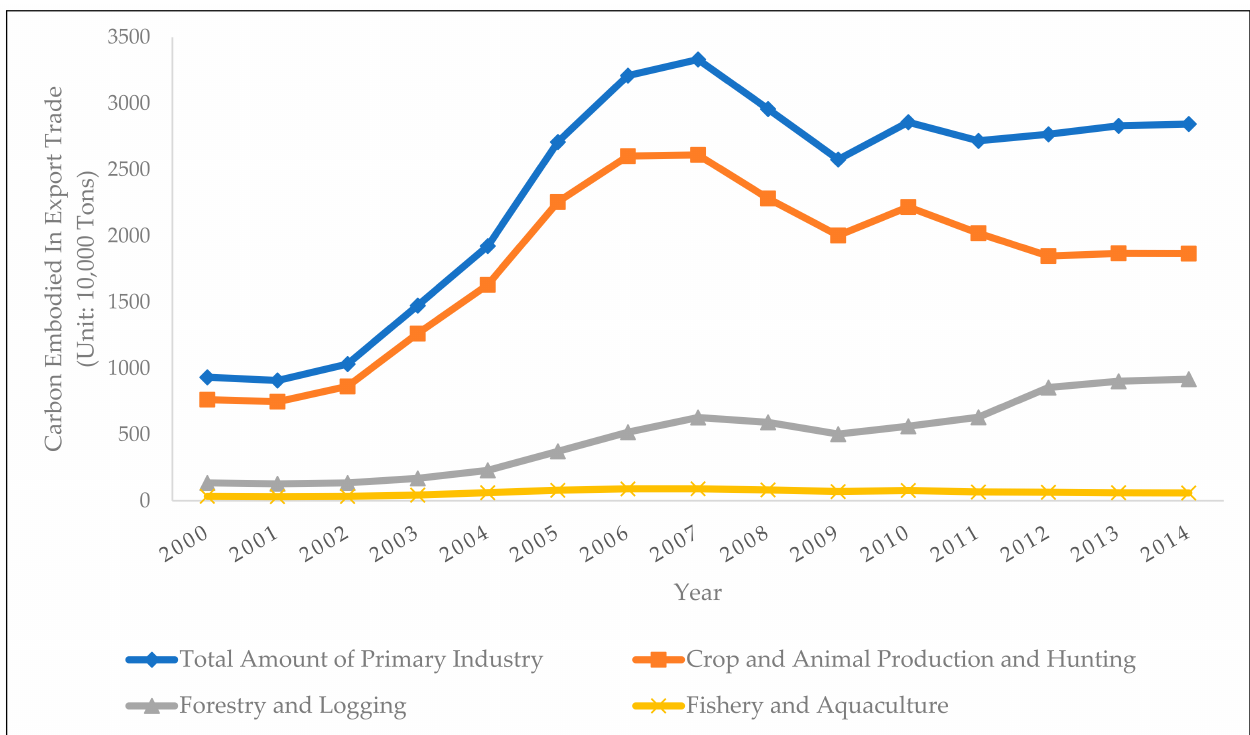
Figure 2. Embodied Carbon in the Export Trade of China’s Primary